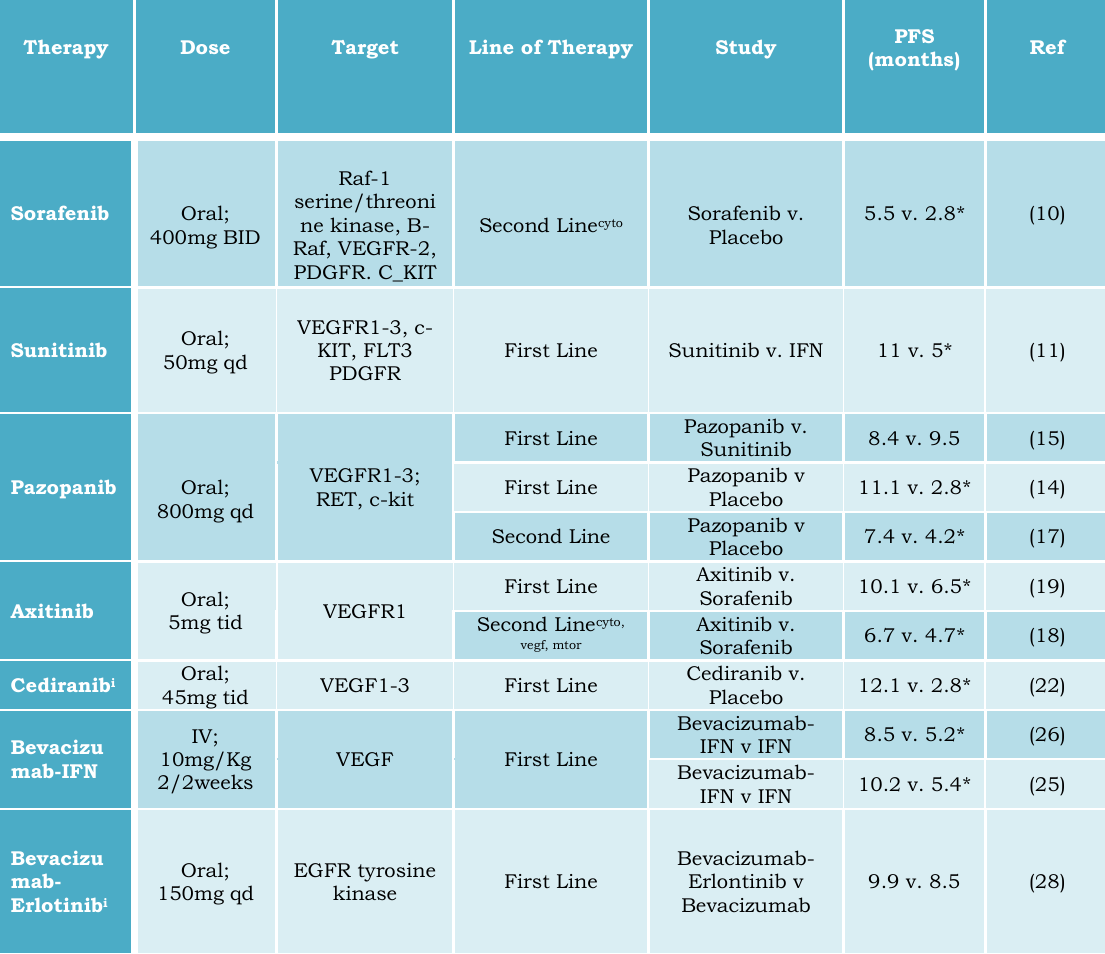
Table 1: Angiogenesis/VEGF inhibitors: dose, molecular target and PFS outcome Therapy Dose Target Line of Therapy Study